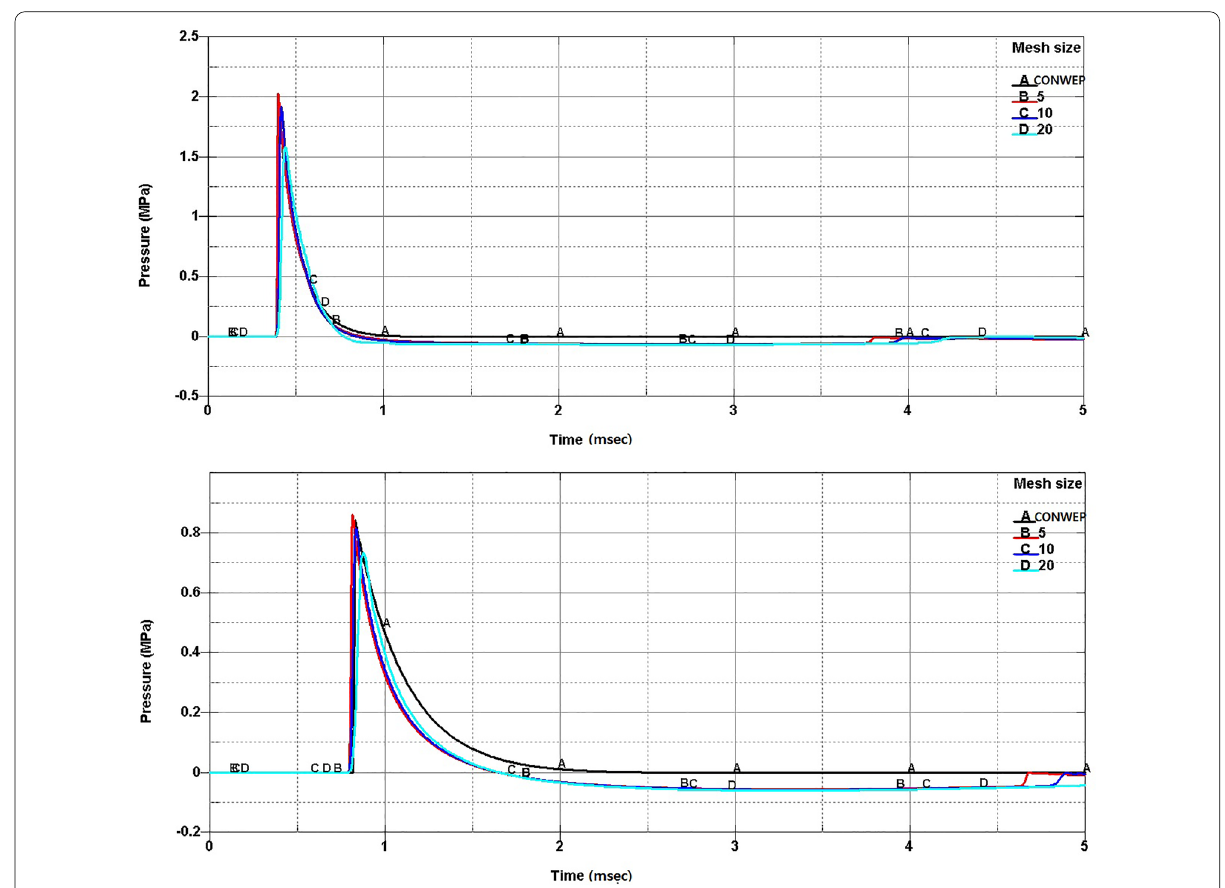
Fig. 12 Pressure behavior with time at distances of 1 m (top) and 1.5 m (bottom) from the 3 kg TNT detonation position.